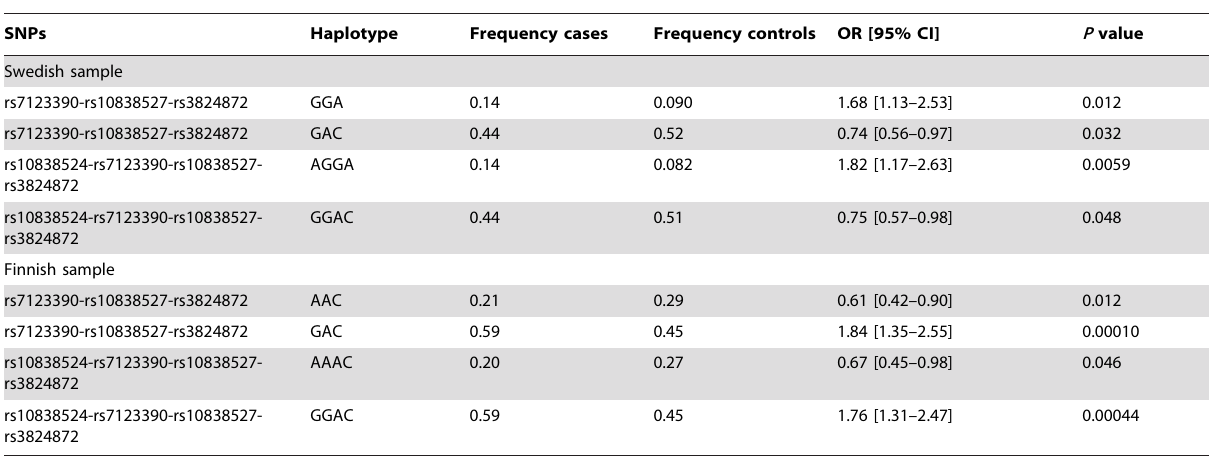
Table 3. Haplotype association